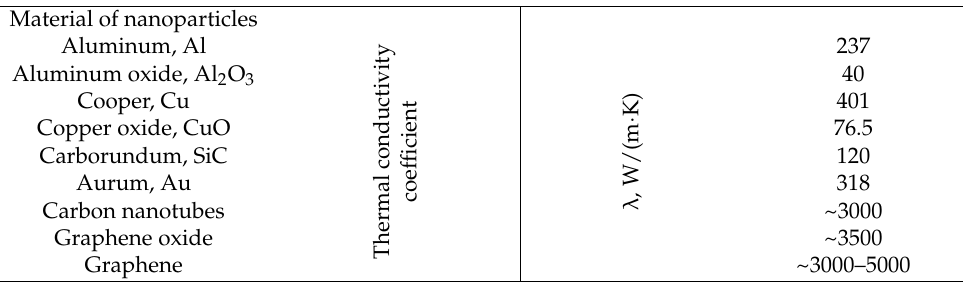
Table 1. The values of thermal conductivity coefficient λ , W at temperature 20 ◦ C